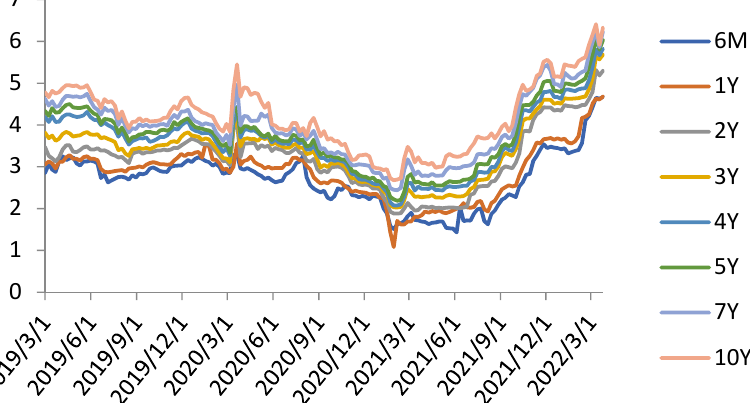
Figure 2. Romanian government bond yields between March 2019 and March 2022. Source: Bloom- berg.